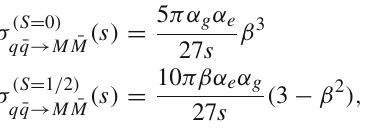
Fig. 2 Total cross section for monopole–antimonopole pair annihila- tion M ¯ M → q ¯ q as a function of the center-of-mass energy different values of the monopole mass M . Plots in the top and bottom panels describe spin-zero and spin-half monopoles,